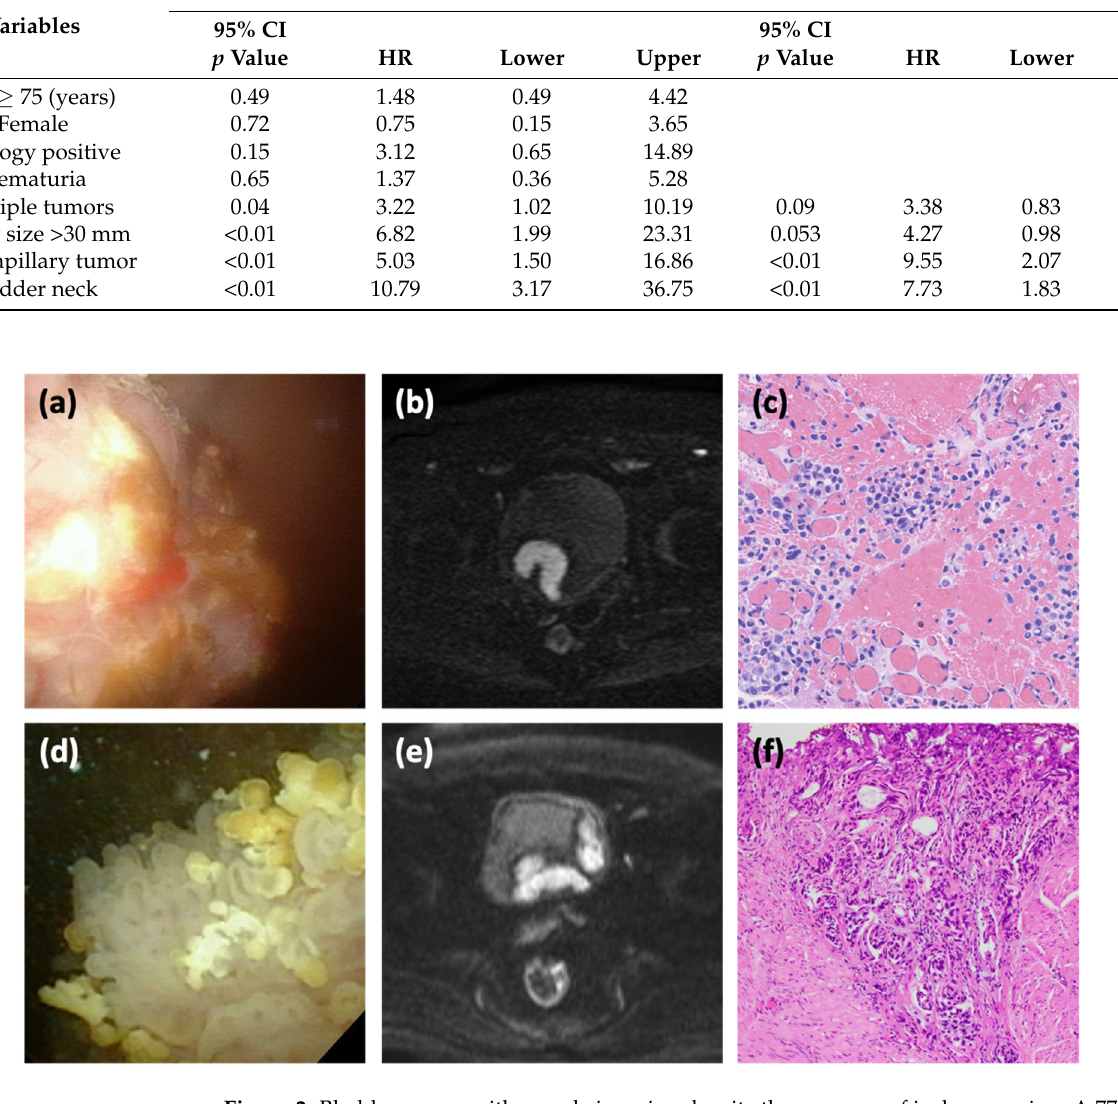
Figure 2. Bladder cancer with muscle invasion despite the presence of inchworm sign. A 77-year-old man consulted for hematuria ( a – c ). Cystoscopy shows a non-papillary tumor on the right wall ( a ); DW-MRI shows the inchworm sign ( b ); and TURBT shows tumor invasion into the muscle layer, and the diagnosis of MIBC was made ( c ). A 76-year-old man referred for urinary frequency and gross hematuria ( d – f ). Cystoscopy reveals a papillary tumor in the neck ( d ). MRI shows a bladder tumor with inchworm sign and multiple tumors on the lateral wall of the bladder ( e ). The resected tissue of the neck tumor shows findings of muscle invasion ( f